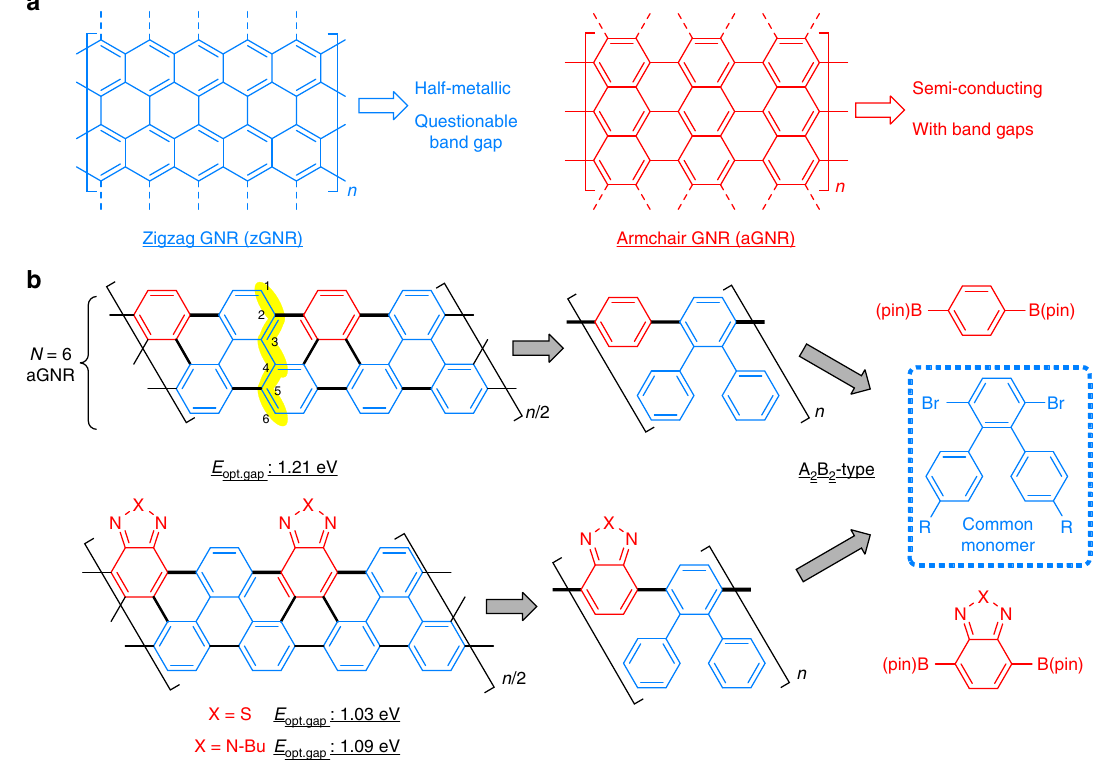
Fig. 1 Graphene nanoribbons (GNRs). a Zigzag and armchair graphene nanoribbons (aGNRs). b A modular approach for aGNR synthesis. N : the number of dimer lines. n : the number of repeating units. pin: pinacol group. E opt.gap : optical band-gap